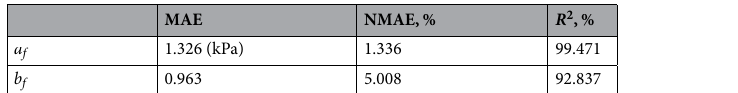
MAE NMAE, % R 2 , % a f 1.326